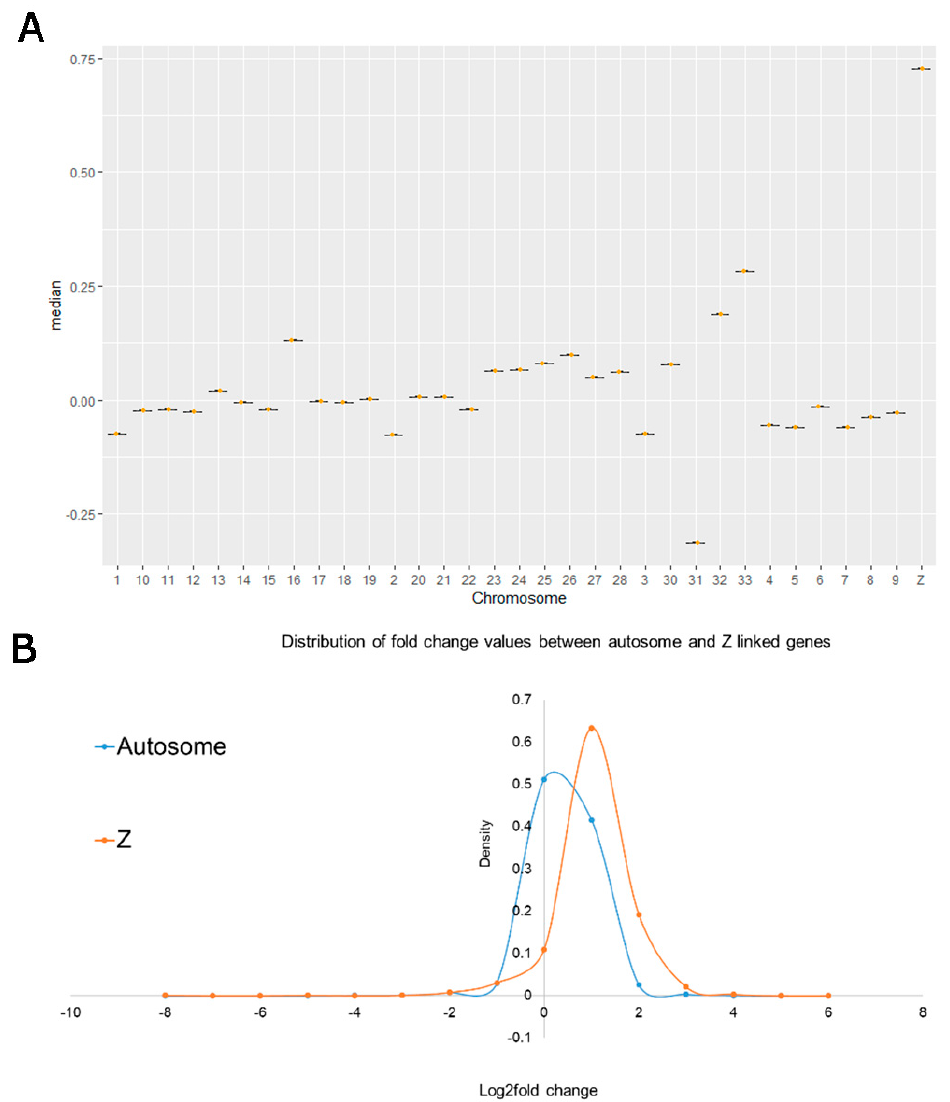
Figure 5. ( A ) Chromosome-wise folding changes the expression of genes in the cultured PGCs. The boxplot shows the median of log2 male to female fold change values per chromosome. The median value for the Z chromosome is the highest compared to all other chromosomes. ( B ) Comparison of the fold change distribution of autosomes and Z chromosome-linked genes. The peak density of Z-linked chromosome genes is slightly less varied than the density of autosomal genes. It shows that overall, Z chromosome-linked genes have higher log2 fold change values than autosomes.